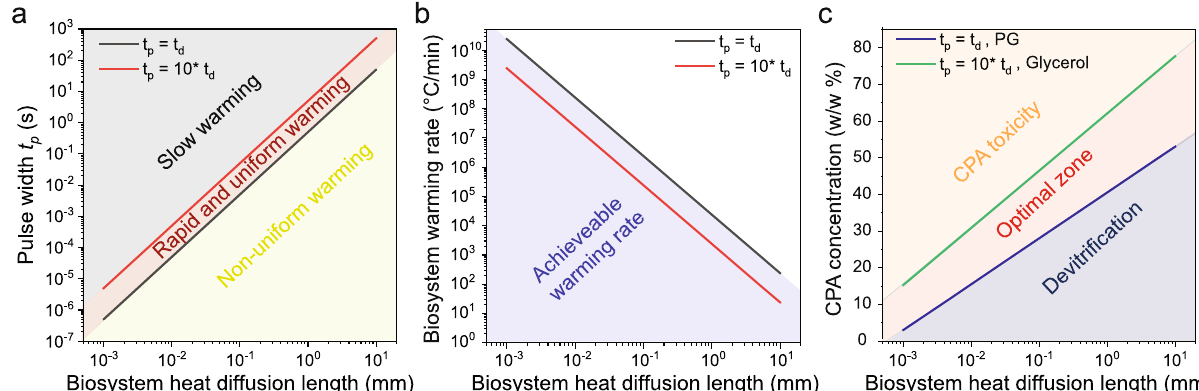
Fig. 6 | Design and physical limits of joule heating as the external heat source for rewarming. a To achieve rapid and suf fi ciently uniform rewarming (area in red), the pulse width ( t p ) can be selectedbasedon biosystem heat diffusion length ( h ). When the pulse width is much smaller than heat diffusion time ( t d = h 2 /2 α , α is the thermal diffusivity of the biosystem: 10 − 6 m 2 /s was used for the calculation), non-uniform warming occurs. For longer pulse widths (i.e.,>10 t d ), the achieved rewarmingrateisslow.Weassumesuf fi cientlyuniformrewarmingcanbeachieved using t p =1~10 t d . b Achievablewarmingrateinsidethebiosystemsasafunctionof biosystem heat diffusion length. The black and red lines represent the warming rates(calculatedas200°C /t p )when t p =t d and t p = 10 t d ,respectively.Theachieved warmingratedecreaseswithincreasingpulsewidth. c